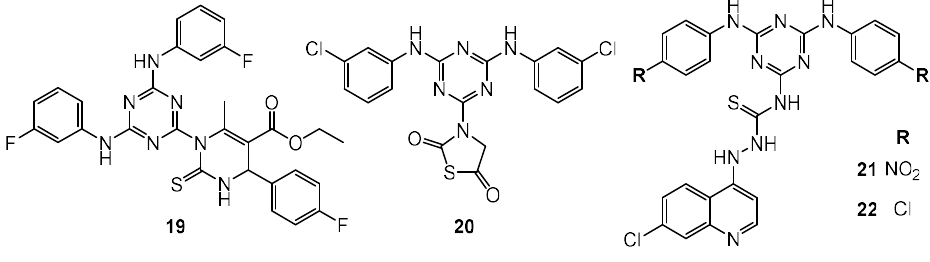
Figure 5. Structure of EGFR inhibitors.